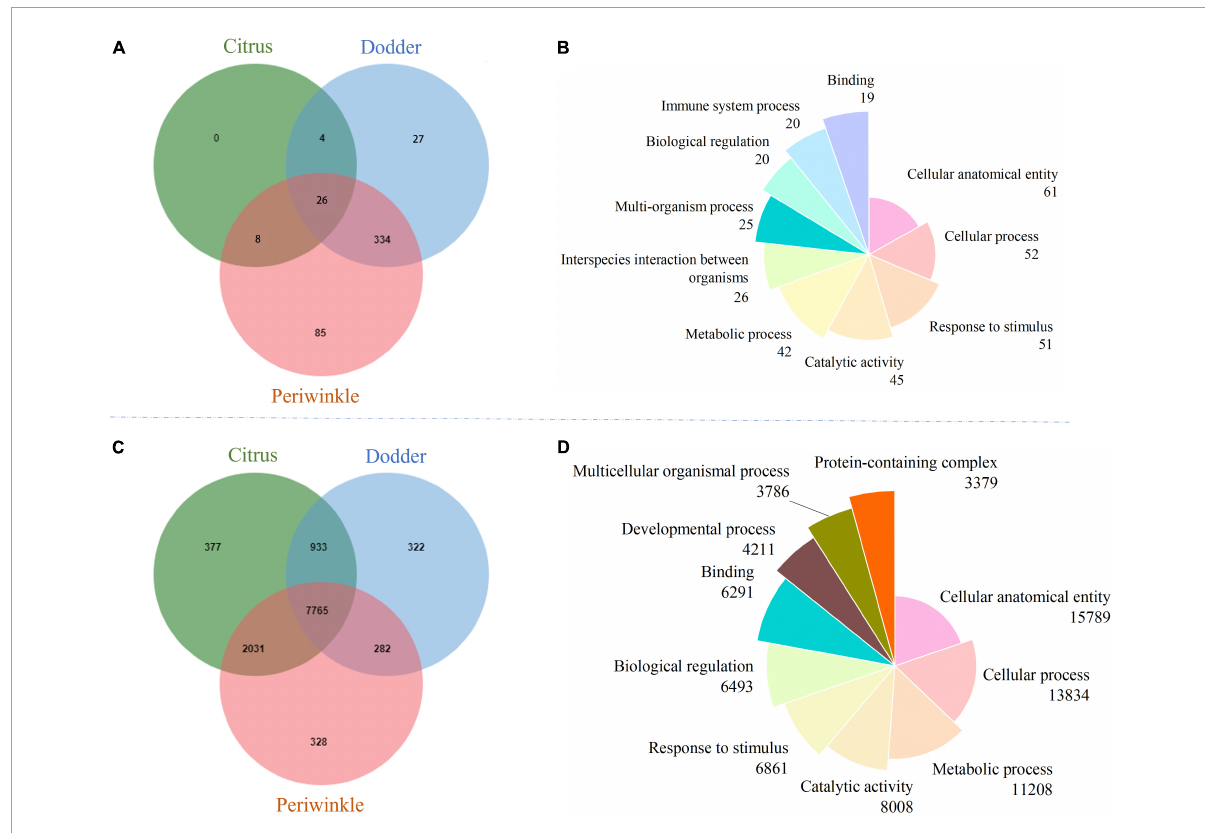
FIGURE4 Orthologous cluster analysis and GO function annotation of mobile and non-mobile transcripts from dodder, citrus and periwinkle. (A) The Venn diagram showed the orthologous cluster of mobile transcripts among three species. (B) The pie chart showed the GOSlim terms distribution of the orthologous cluster for common mobile transcripts among three species. (C) The Venn diagram showed the orthologous cluster of non-mobile transcripts among three species. (D) The pie chart showed the GOSlim terms distribution of the orthologous cluster for common non-mobile transcripts among three species. The number of transcripts that classified to each GOSlim term was listed below the name of term. The detailed GO information of mobile and non-mobile transcripts was listed in Supplementary Table 3